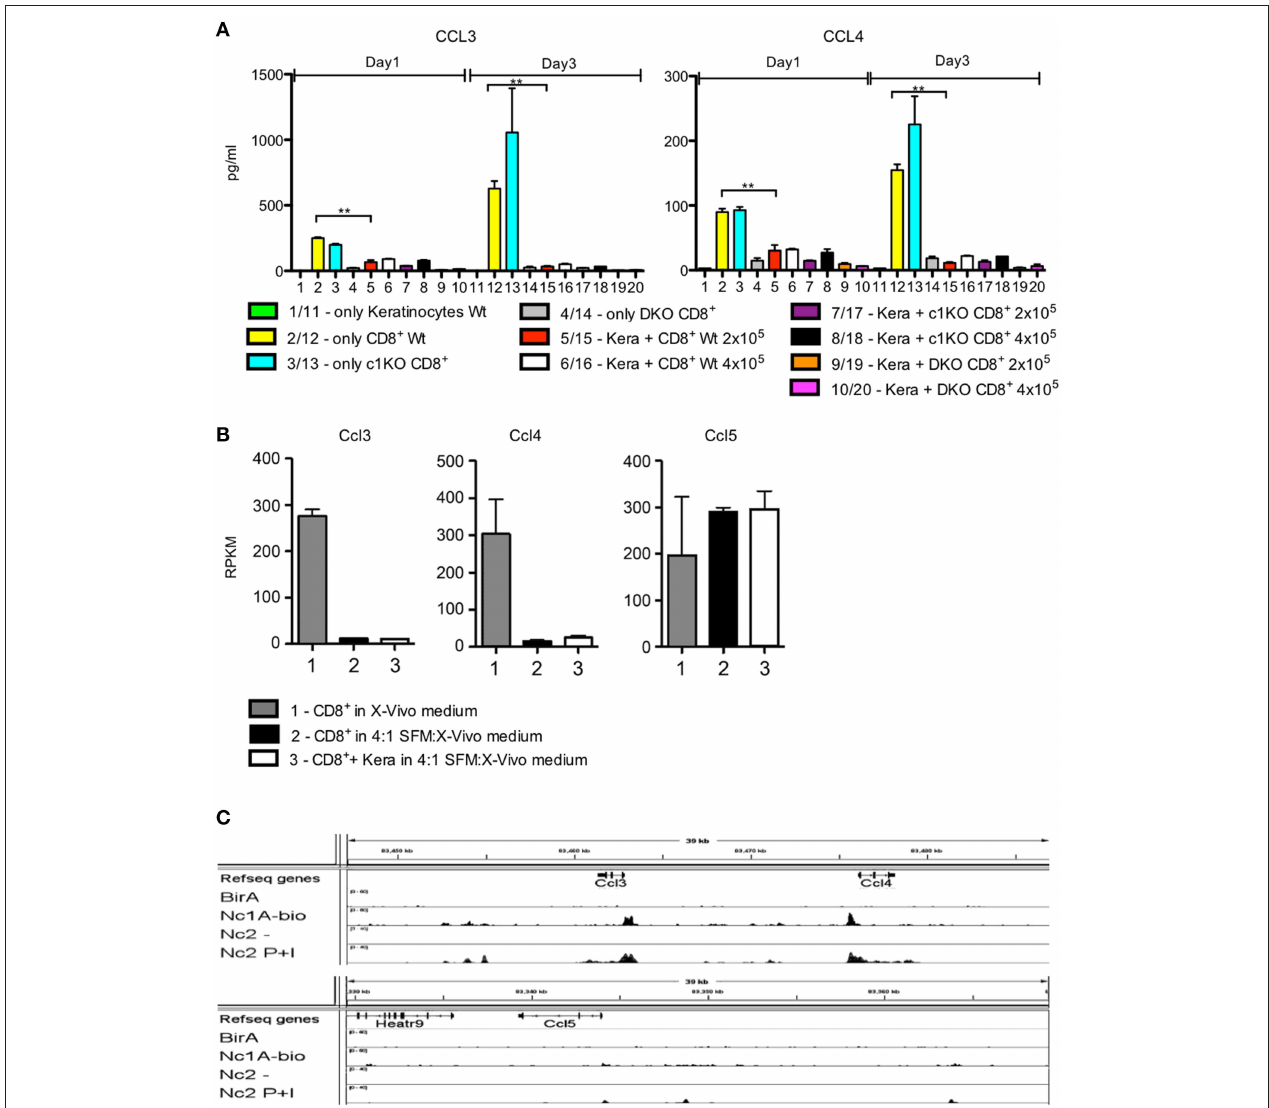
FIGURE 3 | Silencing of CCL3 and CCL4 secretion in keratinocyte medium. (A) Secretion of chemokines CCL3 and CCL4 by keratinocytes, CD8 + T cells, or co-cultures of both. Keratinocytes cultured for 7 d in vitro and splenic CD8 + T cells pre-activated by α CD3/CD28 Ab for 1 d were either cultured alone or together in 6-well plates for 1 or 3 d as indicated and their chemokine secretion was measured. (B) Suppression of Ccl3 and Ccl4 , but not of Ccl5 transcription upon culture of pre-activated CD8 + T cells for 1 d in keratinocyte/X-vivo medium (4:1) alone (column 2) or in the presence of keratinocytes (column 3). Column 1 shows the RNA levels of genes in pre-activated CD8 + T cells cultured in X-vivo medium for 1 d. (C) Binding of NFATc1-bio protein to the promoters of murine Ccl3 and Ccl4 genes in activated cytotoxic T cells. Results of ChIP seq assays (16). Splenic CD8 + T cells from transgenic mice expressing NFATc1-bio proteins were stimulated by T + I for 5h. Their chromatin was cross-linked by 4% formaldehyde-treatment of cells in vitro , followed by shearing of chromatin and binding to streptavidin beads. After the release of DNA from cross-linked chromatin complexes, DNA was sequenced in NGS assays (16, 20), * p < 0.05, ** p < 0.005, *** p <